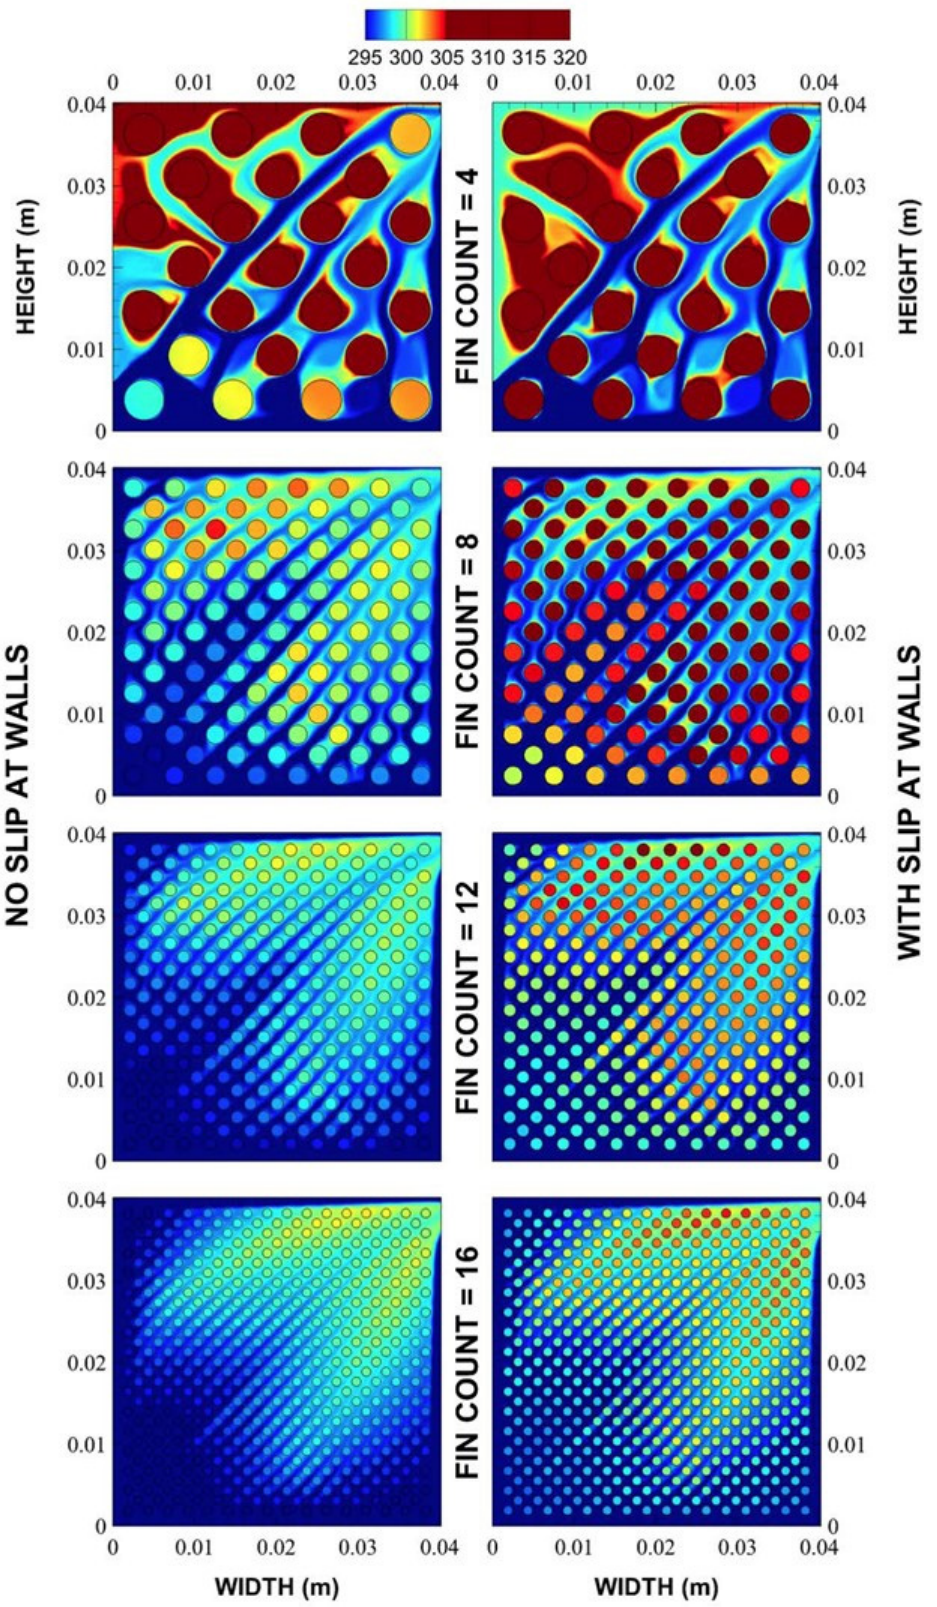
Figure 4. Temperature (K) distribution in the solution domain at the midheight of the fin for hydrophobic and hydrophilic fin surfaces for various number of fins and Re = 500.